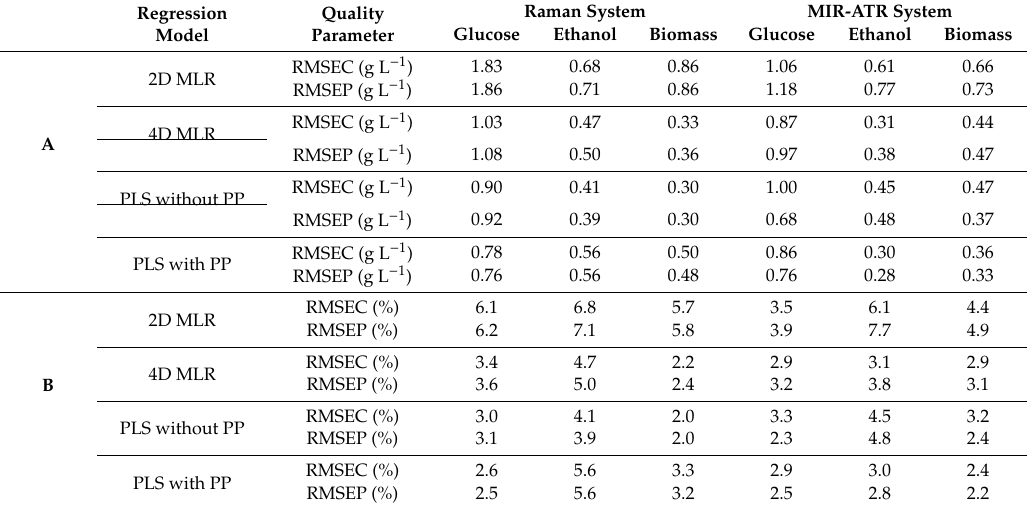
Raman System MIR-ATR System Quality Glucose Biomass Parameter